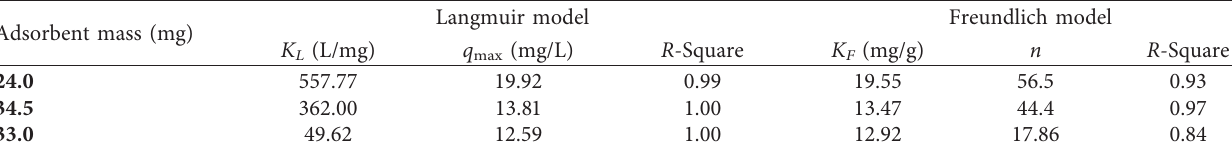
Figure 8: Freundlich isotherm model fit for (a) 24mg, (b) 34.5mg, and (c) 33 mg combined mass HAP-BENT adsorbents. Table 3: Isotherm model parameters for HAP-BENT best adsorbents.